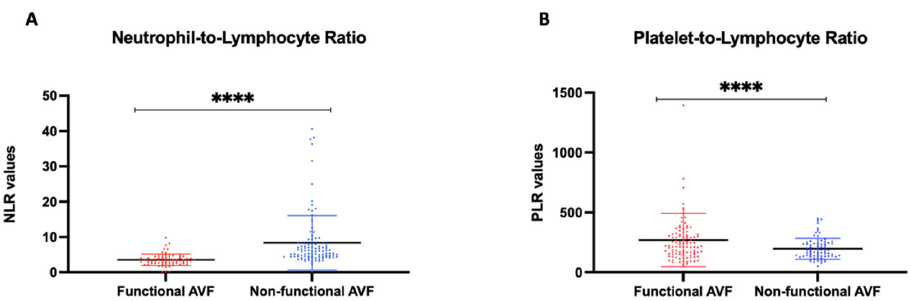
Figure 2. Biochemical marker differences between AVF functioning and AVF malfunctioning groups. ( A ) Neutrophil-to-Lymphocyte Ratio mean value and Standard deviation between Functional and Non-Functional Arterovenous fistula; ( B ) Platelet-to-Lymphocyte Ratio mean value and standard deviation between Functional and Non-Functional Arterovenous fistula. Asterisks indicated the highly significant differences between values.